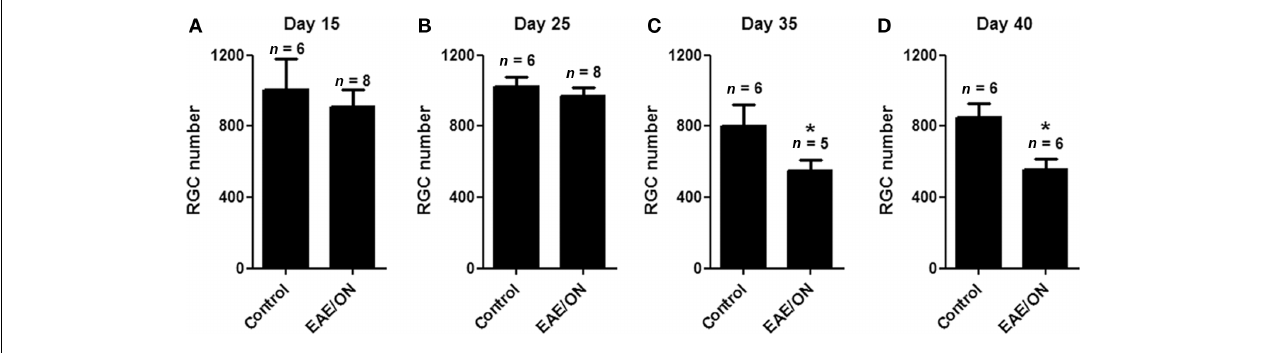
inflammatory cell infiltrates. (A) No difference in RGC numbers was found between control eyes and EAE eyes with ON 15days post-immunization. (B) No difference in RGC numbers was observed at day 25. (C) At day 35, EAE ON eyes had fewer remaining RGCs than control eyes (* p = 0.048). (D) At day 40, similar RGC loss was found in EAE ON eyes (* p =